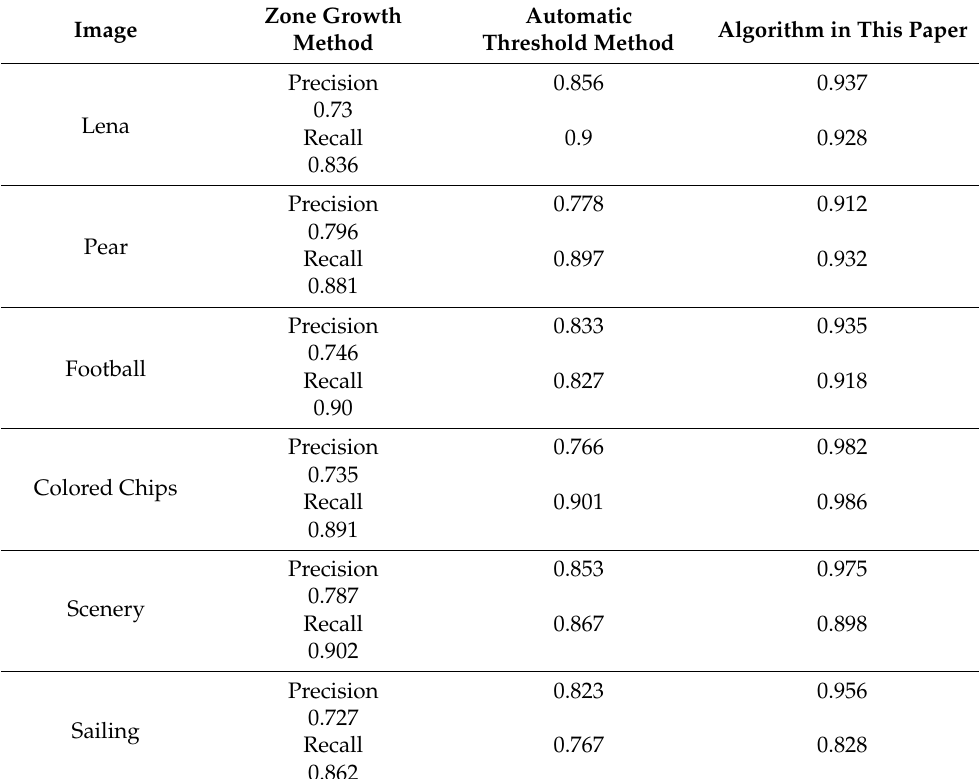
Table 2. Comparison table of accuracy and recall rate of the algorithm.